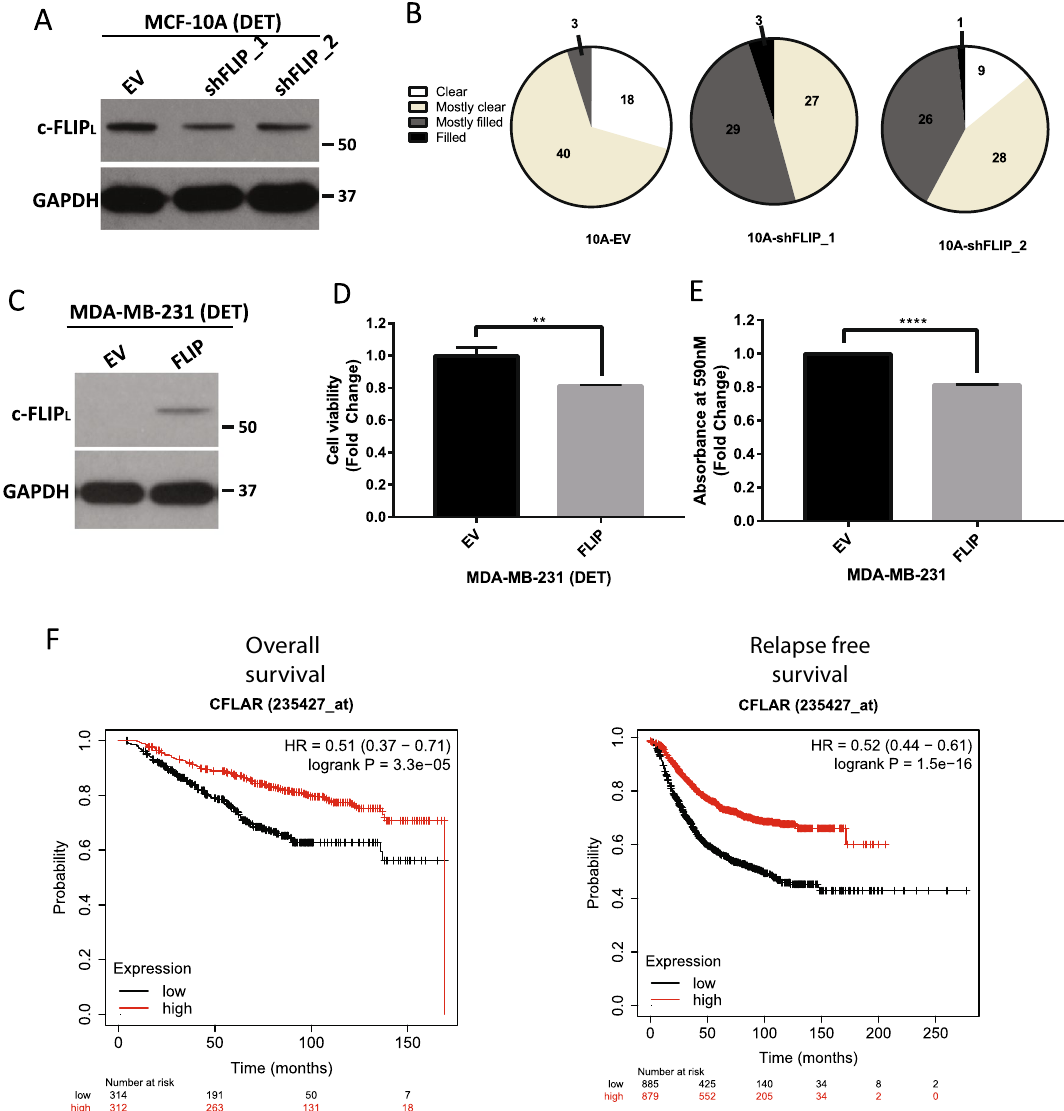
Figure 5. c-FLIP L negatively impacts ECM-detached cell growth. ( A ) MCF-10A cells were stably transfected with shRNA targeting c-FLIP L and efficacy was verified with western blot. ( B ) 10A-EV, 10A-shFLIP1 and 10A-shFLIP2 cells were grown in 3D Matrigel Assay and were allowed to form acinar structures for 18 days. Structures were stained and luminal clearance was scored as described. 10A-EV n = 61, 10A-shFLIP1 n = 59, 10A-shFLIP2 n = 64. ( C ) c-FLIP L was overexpressed in MDA-MB-231 cells and verified by western blot. ( D ) Measurement of cell viability MDA-MB-231 cells during ECM-detachment using CellTiter-Glo Luminescent Cell Viability Assay after 48 h. ( E ) Long term clonogenic assay of MDA-MB-231 cells tested as described and stained with crystal violet assay. Absorbance of extracted crystal violet at 590 nM is shown. ( F ) Correlation of c-FLIP L expression to overall survival and relapse-free survival of patients with breast cancer. c-FLIP L expression is differentiated as low (black) vs high (red) expression against the median expression. Overall survival was analyzed using KMPlotter (http:// www. kmplot. com). Graphs show representative data from a minimum of three biological replicates and all western blotting experiments were independently repeated a minimum of three times with similar results. Statistical significance was determined using Student’s two-tailed t test. Error bars show standard to form colonies (Fig. 5E). Given the data that lower levels of c-FLIP L may facilitate the growth of ECM-detached cancer cells, we hypothesized that low levels of c-FLIP L may be associated with poor clinical outcomes owing to tumor cell dissemination. Indeed, analysis of data derived from breast cancer patients revealed that lower levels of CFLAR expression was linked to poor patient outcomes as measured by diminished overall survival and relapse-free survival (Fig. 5F).